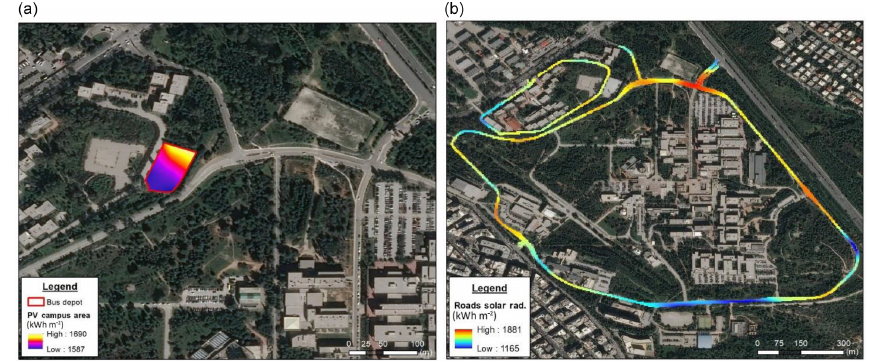
Figure 4. (a) Solar radiation at the open space PV area (scenario 2) and (b) at the solar roads surface (scenario 3). (Base Map Layer: Bing Map v.7, Bing Satellite Base